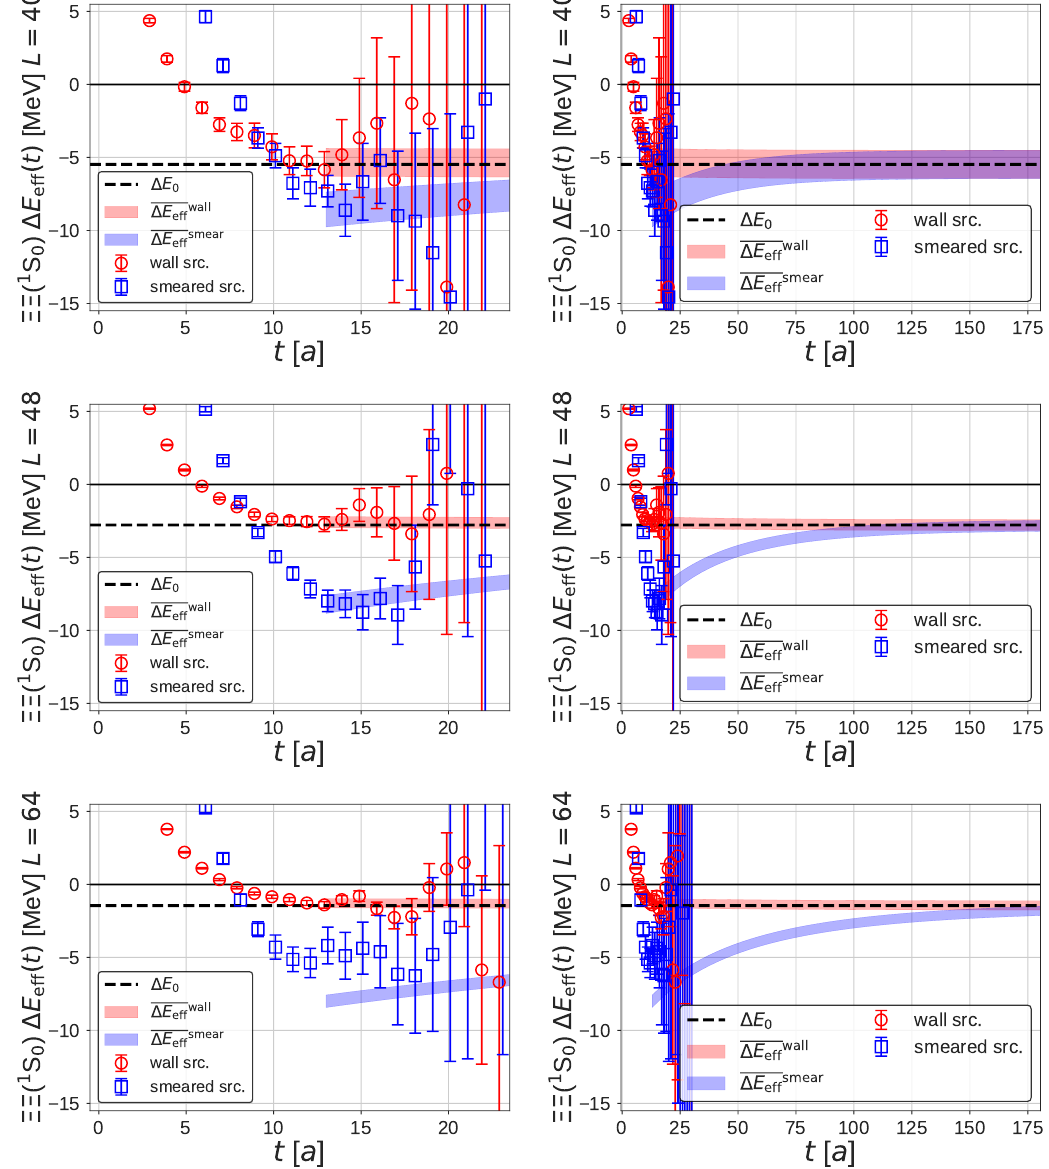
Figure 15 . The reconstructed e(cid:11)ective energy shifts (cid:1) E e(cid:11) ( t; t 0 = 13 a ) for the wall source (red bands) and the smeared source (blue bands) at L = 40, 48 and 64. The e(cid:11)ective energy shifts in the direct method are also shown for the wall (red circles) and smeared (blue squares) sources. The black dashed lines are the energy shifts for the ground state of the HAL QCD Hamiltonian in the (cid:12)nite volume evaluated at t 0 =a = 13. (Left) 0 (cid:20) t=a (cid:20) 24. (Right) 0 (cid:20) t=a (cid:20)